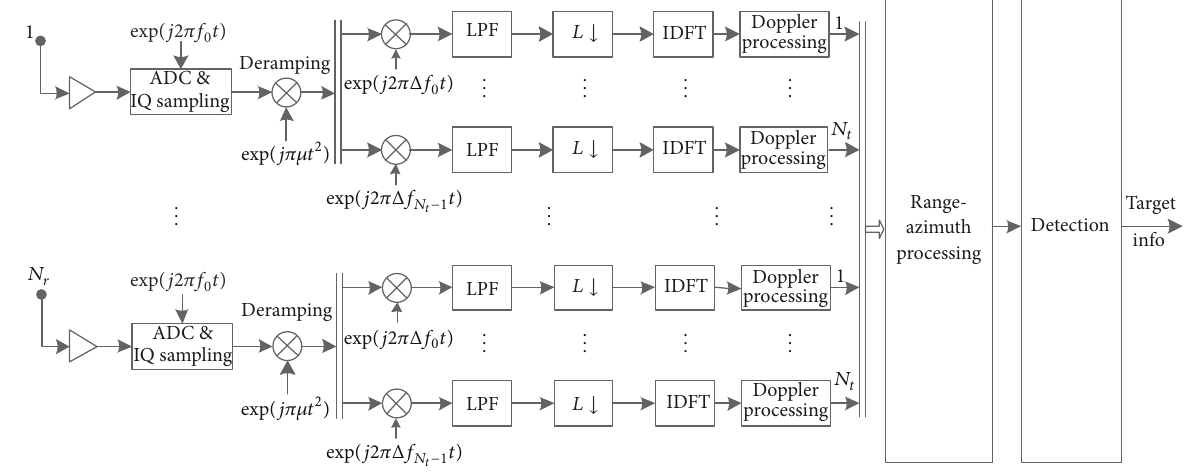
Figure 4: Receiver and signal processor structure of the proposed